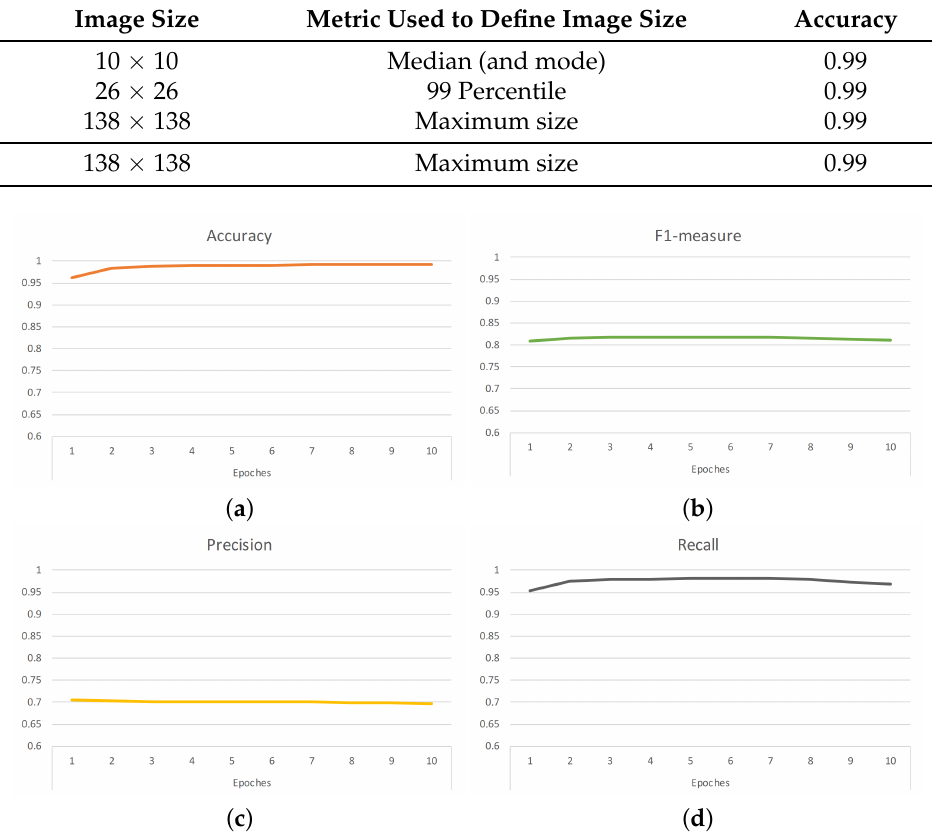
Table 4. Accuracy of the CNN trained with different initial parameters of the training dataset.